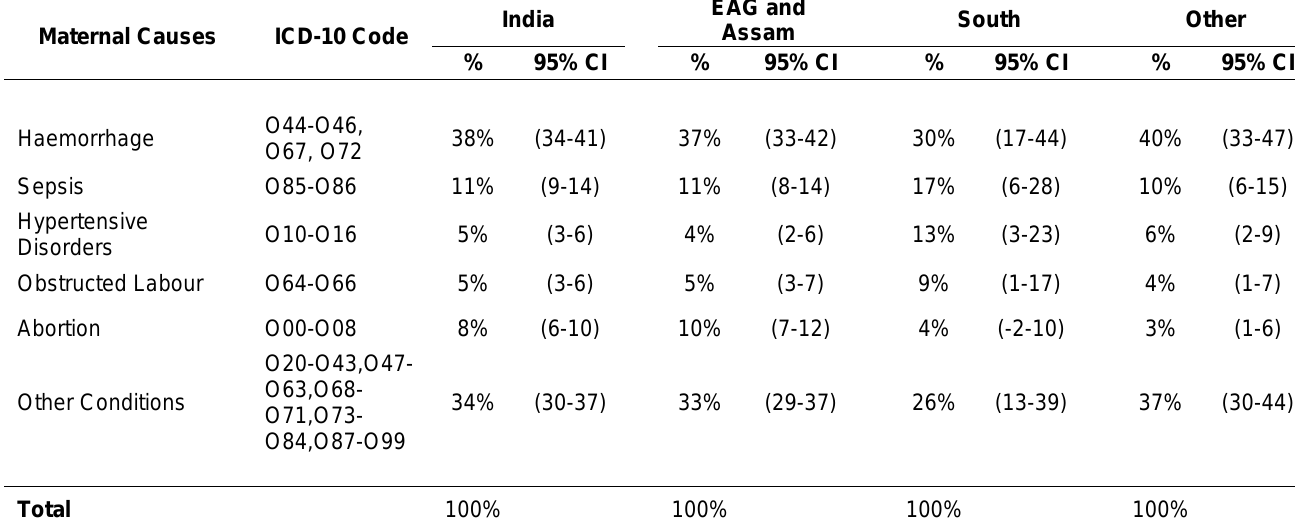
Table 5: Causes of Maternal Deaths from 2001-03 Special Survey of